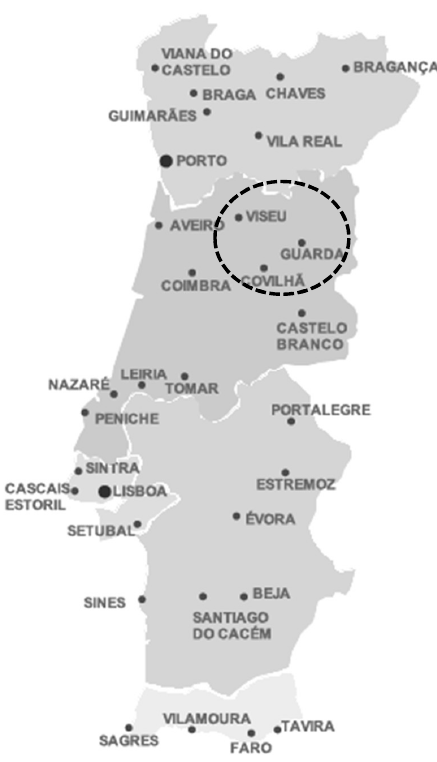
Figure 1. Map of Portugal showing the location of Viseu and Covilhã.